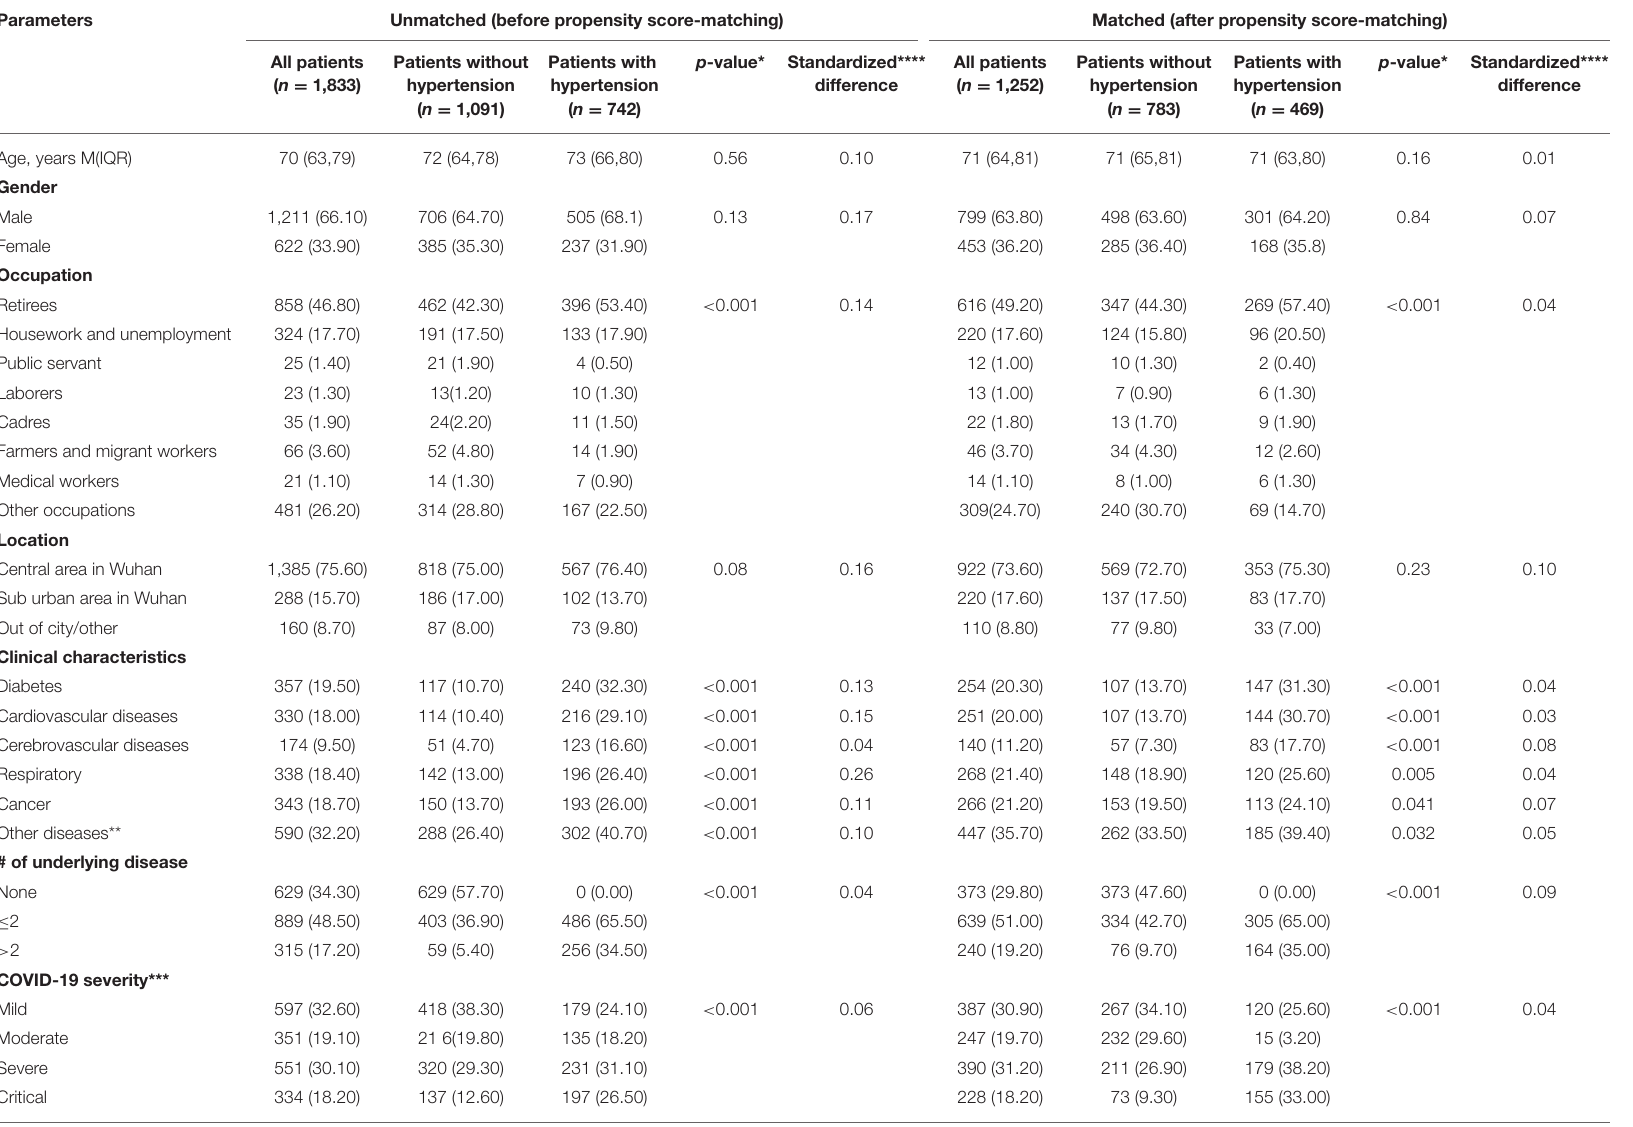
TABLE 1 | The epidemiological, clinical, and social characteristics of deceased COVID-19 patients at the early stage of the epidemic in Wuhan, China (Overall and stratified by the patients’ hypertensive status) before and after propensity score-matching for age and sex. Parameters Unmatched (before propensity score-matching) Matched (after propensity